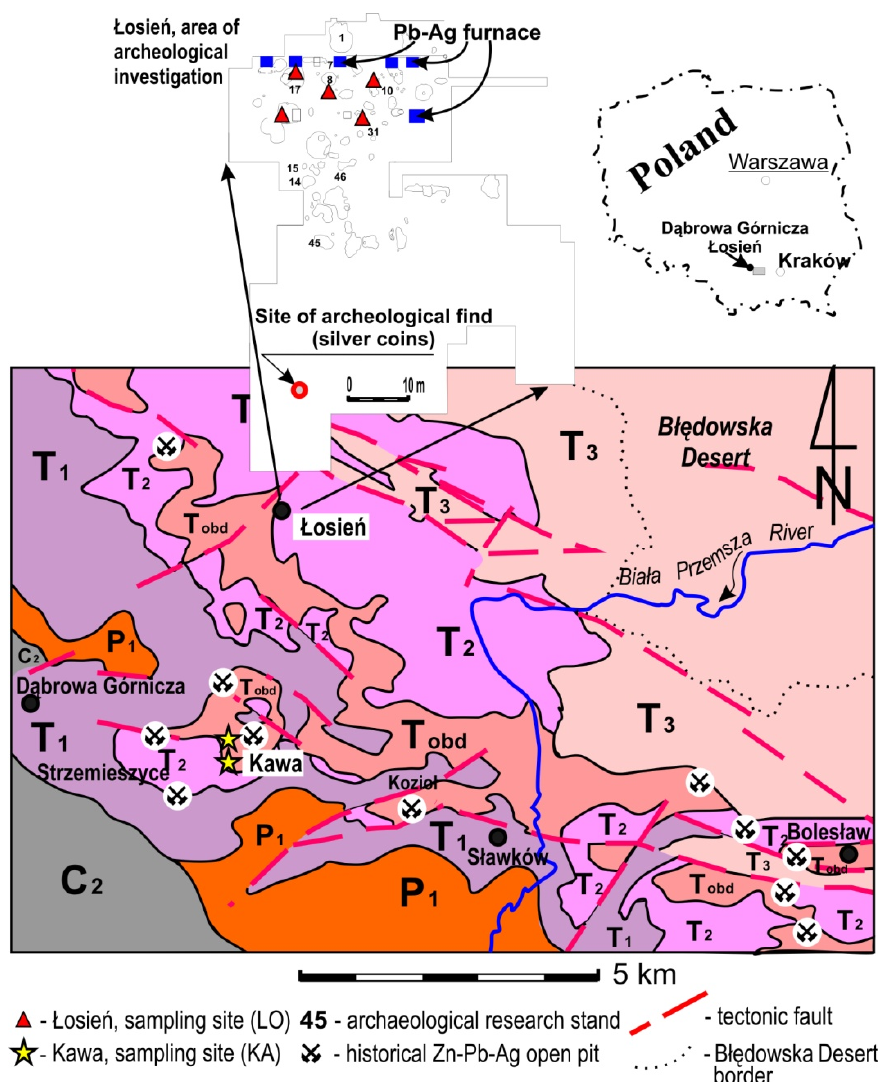
Figure 1. Geological sketch of the study area (without Pleistocene deposits). Explanations: C2—Upper Carboniferous—USCB border, P1—Lower Perm, T1—Lower Triassic, T2—Middle Triassic, T3—Upper Triassic, Tobd—Ore-bearing dolomites with Zn-Pb-Ag mineralization.